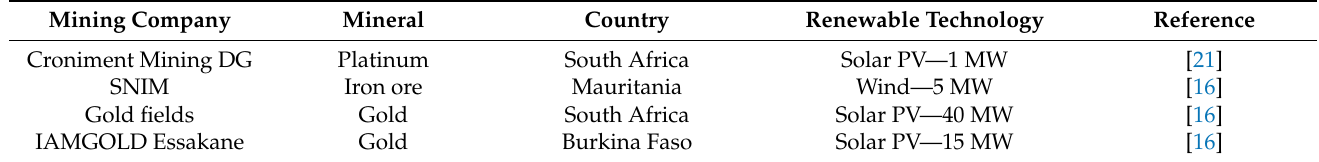
Table 2. Mining companies in sub-Sahara Africa that have integrated renewable